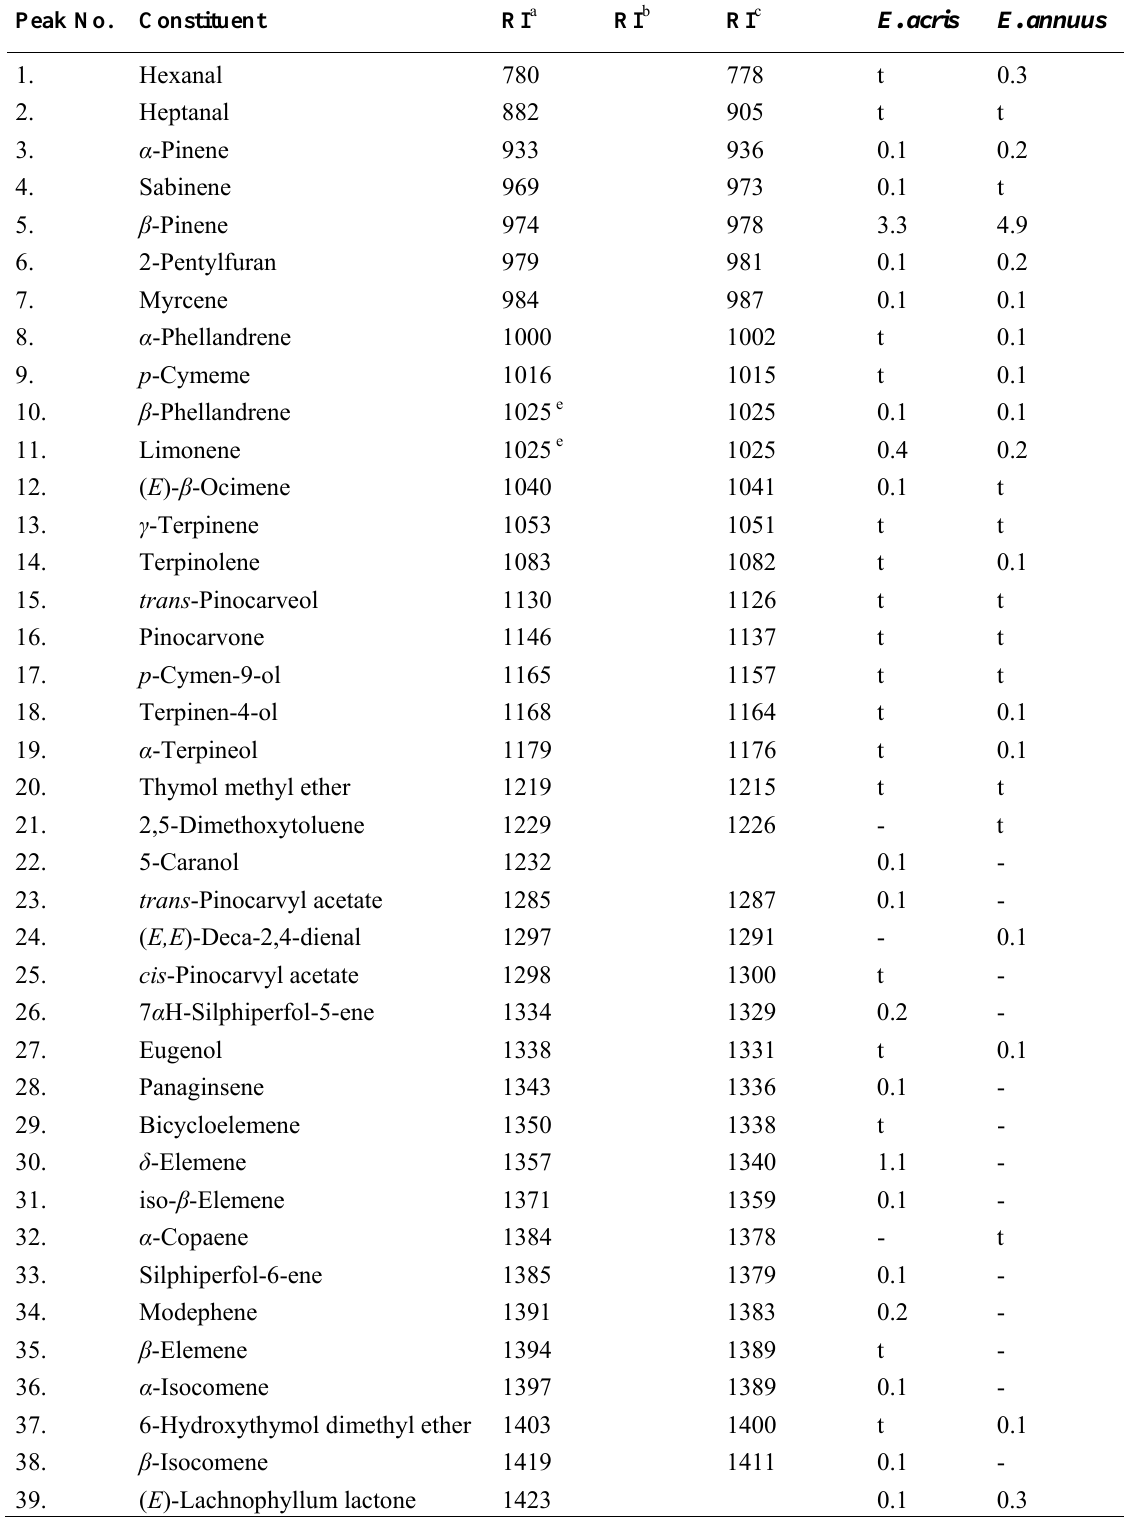
Table 1. Chemical composition (%) of the essential oils from roots of E. acris and E. annuus . Peak